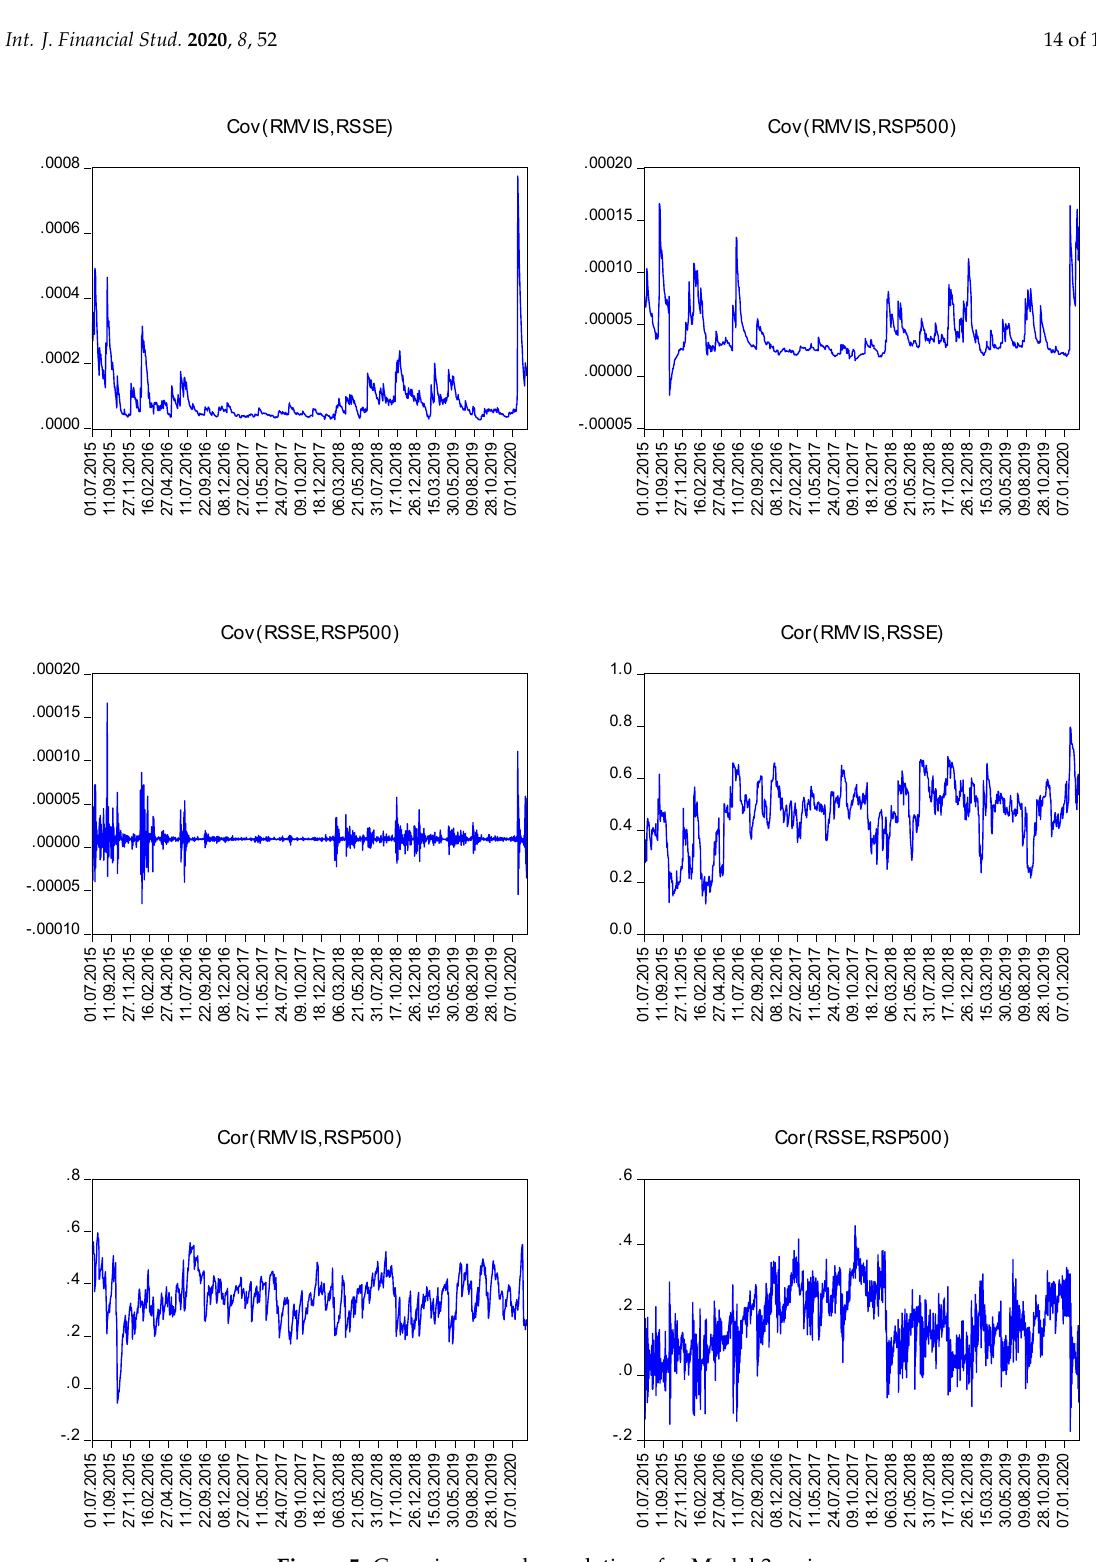
Figure 5. Covariance and correlations for Model 3 series.